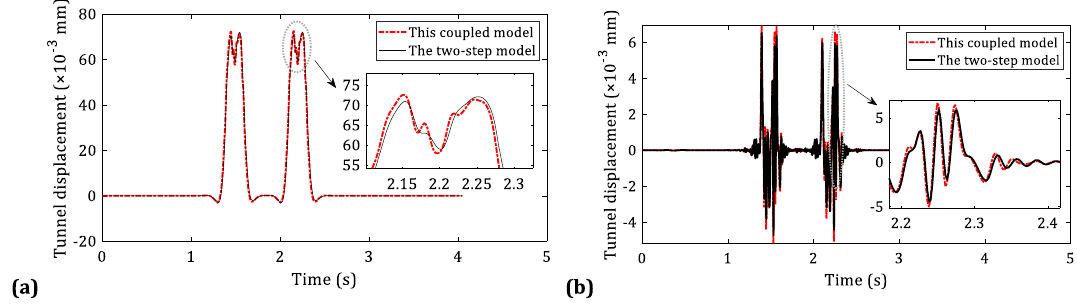
Fig. 23 Comparisons on tunnel displacement: a vertical displacement; b lateral displacement